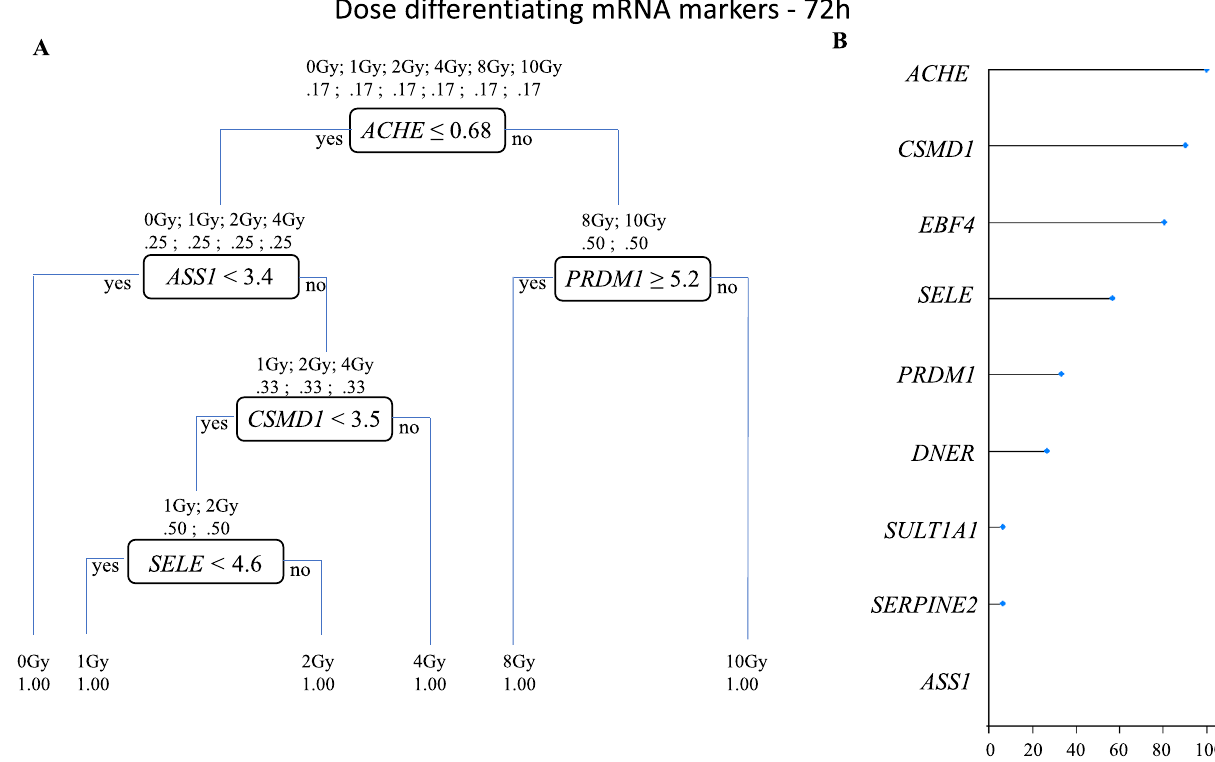
Figure 6. Dose-differentiation mRNA markers at 72 h. ( A ) Decision tree based on the RPART analysis performed in R for dose differentiation at 72 h based on the nine mRNAs at the intersection of all doses in supplementary Fig. 2B. A combination of five mRNAs could differentiate all dose classes. Each node represents an mRNA intensity value based on which a decision is made, and classes are sorted. At the starting node there is a 17% chance of a sample falling into any of the six classes (0 Gy, 1 Gy, 2 Gy, 4 Gy, 8 Gy, 10 Gy). Decision at the first node divides the samples into two groups (0 Gy, 1 Gy, 2 Gy, 4 Gy) and (8 Gy, 10 Gy) at the second step. Two different mRNAs’ intensity values are used to divide the classes further. This process is repeated till all the classes are separated. ( B ) Plot shows relative importance of different mRNAs in dose-separation shown in ( A